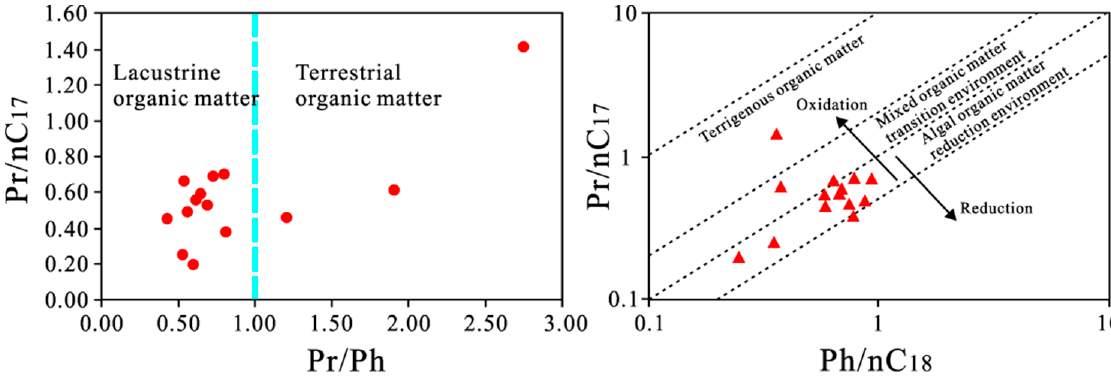
Figure 5. Oil–source correlation results of dark mudstone in Qingshuiying Formation. Red circle and red triangle: values of the dark mudstone samples; Blue line: dividing line of Pr/Ph = 1.